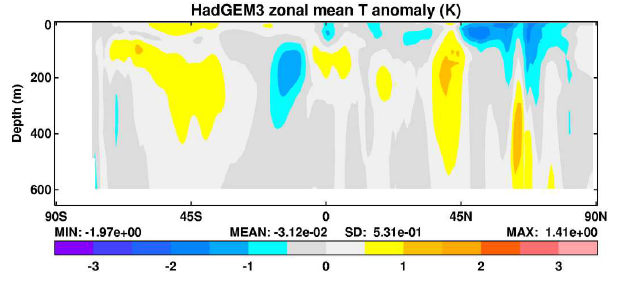
Fig. 13. Zonal mean temperature (K) anomalies with respect to initial conditions for HadGEM3